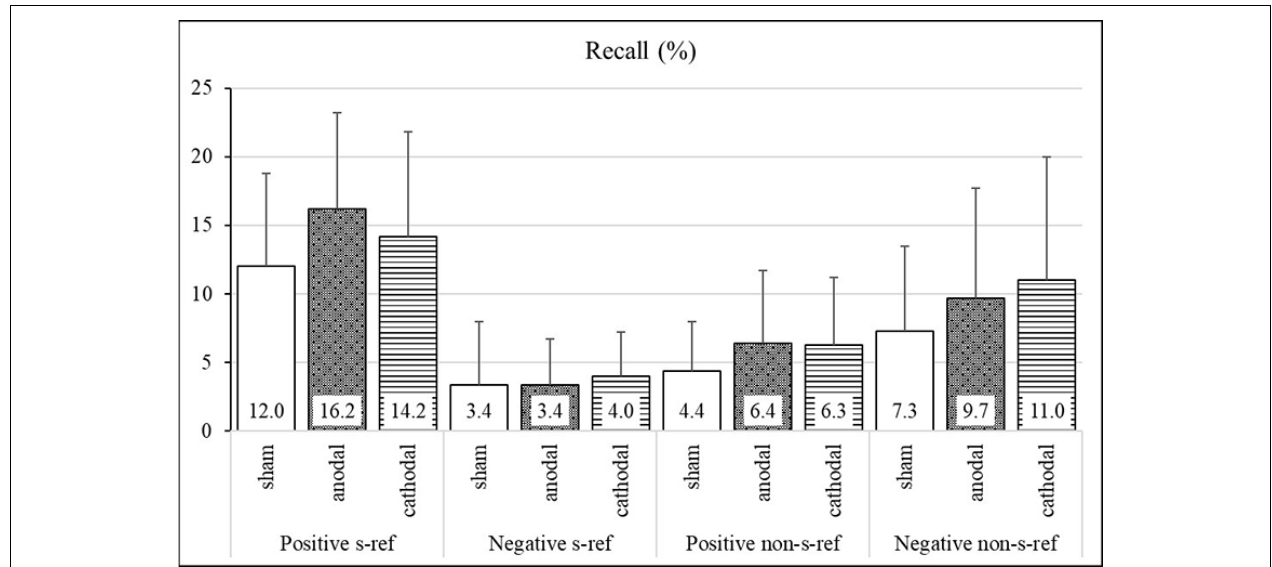
FIGURE 2 | Mnemic neglect effect—percentage of recalled adjectives in the stimulation groups. Group means and standard deviations of the percentage of recalled adjectives (%).